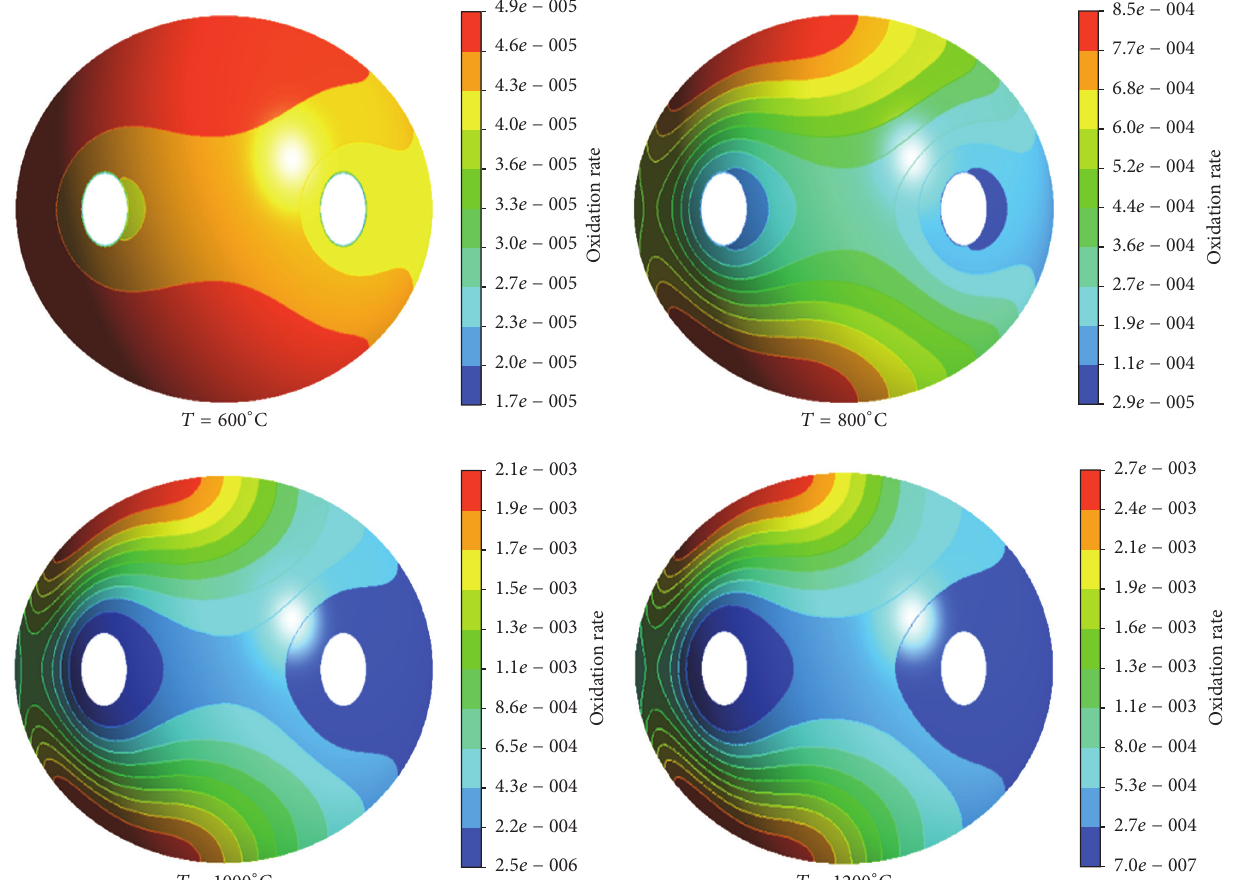
Figure 9: Distribution of oxidation rate with different temperature (Re = 16).